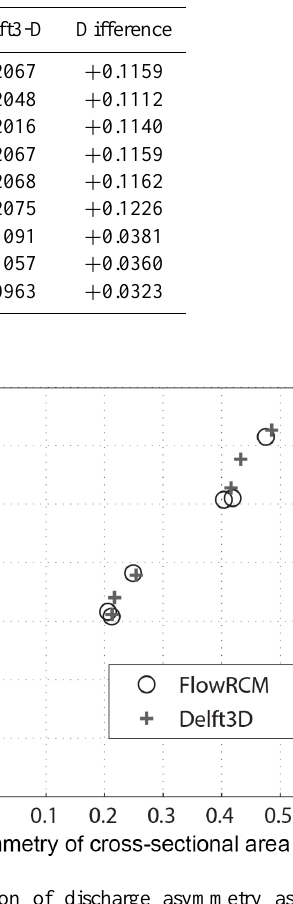
Table 1. Discharge asymmetry and upstream surface elevation results from FlowRCM and Delft3D for all single bifurcation runs. Run Discharge asymmetry (%) Upstream surface elevation (m)